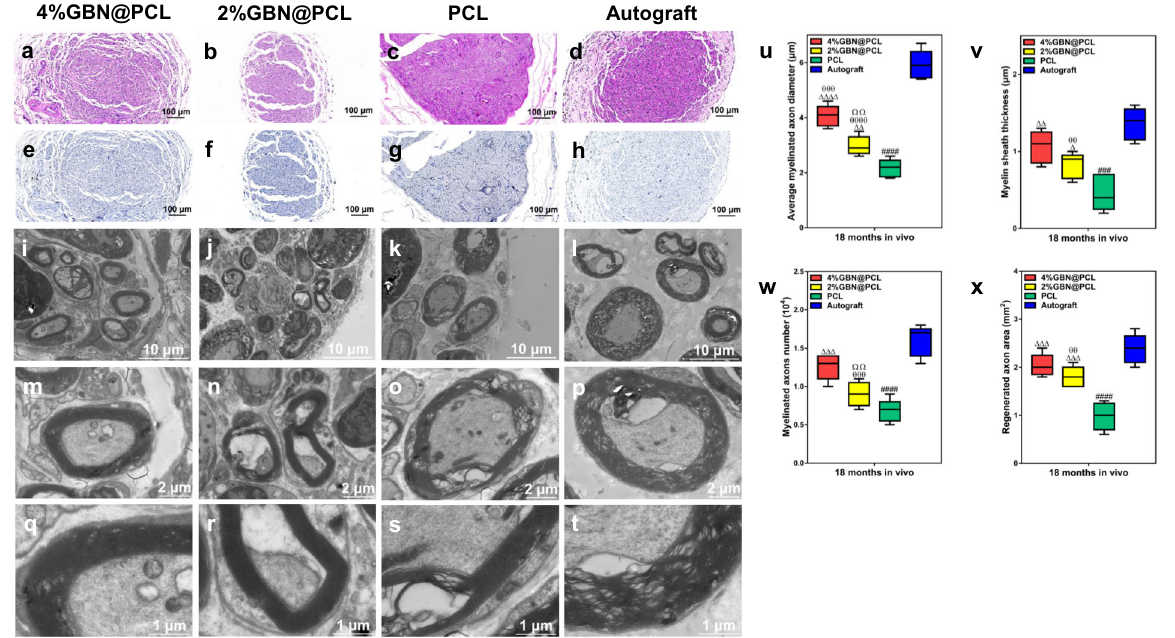
Fig. 2 Structural repair of peripheral nerves by GBN. Morphology of sciatic nerve sections using HE ( a – d ), TB ( e – h ) staining, and transmission electron microscopy ( i – t ). Average myelinated axon diameter ( μ m) ( u ). Myelin sheath thickness ( μ m) ( v ). Myelinated axons number (10 4 ) ( w ). Regenerated axon area (mm 2 ) ( x ). Δ represents p < 0.05, ΔΔ represents p < 0.01, ΔΔΔ represents p < 0.001, ΔΔΔΔ represents p < 0.0001 in comparison with PCL; ### represents p < 0.001, #### represents p < 0.0001 for PCL vs. autograft. θθ represents p < 0.01, θθθ represents p < 0.001, θθθθ represents p < 0.0001 in comparison with autograft. ΩΩ represents p < 0.01 for 4%GBN@PCL vs. 2%GBN@PCL. The center line, bounds of box, and whiskers were displayed in the fi gures,